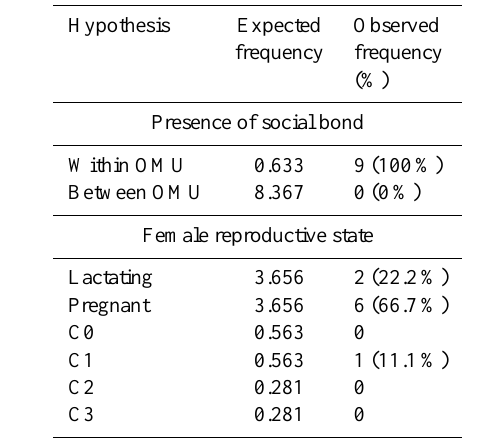
Table 3. Fisher exact test of the difference between the observed and expected values for the hypotheses that meat sharing occurs preferentially based on social relationships or female reproductive